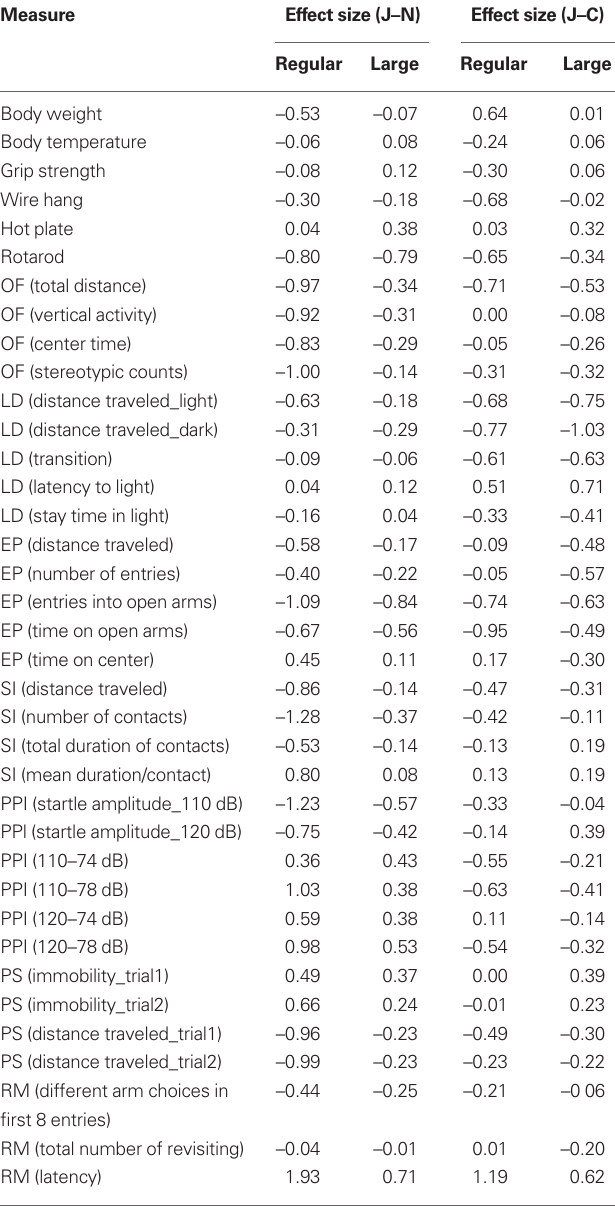
Table 1 | The list of effect size for each behavioral